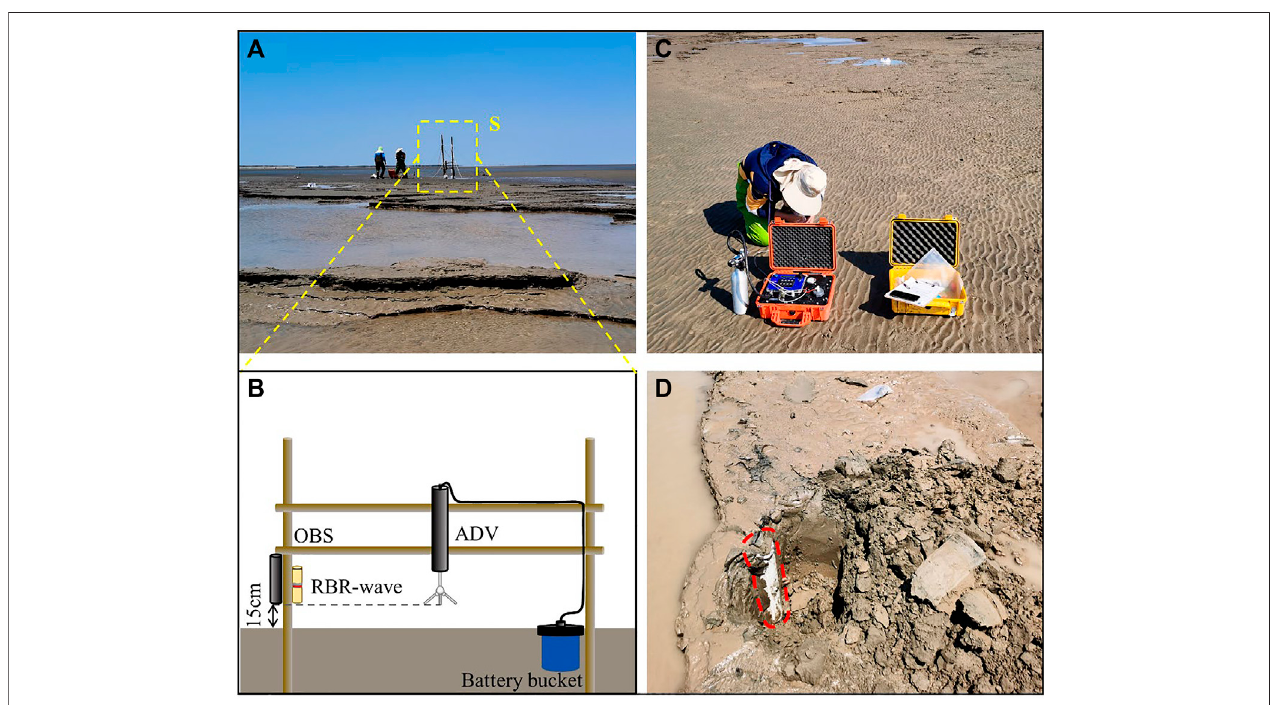
FIGURE 3 | Schematic and photograph of the observation platform and instruments deployed during fi eld measurements. (A) Schematic diagram of the observation platform; (B) Photo of the instrument installation, all instrument sensors are deployed at 15 cm above the seabed; (C) Coherent strength meter (CSM) used to estimate seabed critical erosion shear stress; (D) Sediment core collected on a hummocky patch.